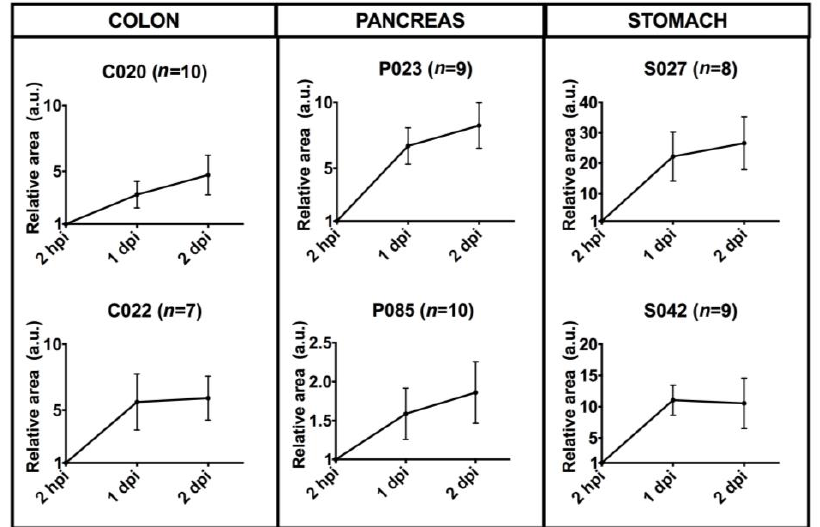
Figure 8. Quantitative analysis of six cases of patient-derived tumor xenografts. Dil-stained area at time points 2 hpi, 1 dpi and 2 dpi were normalized with respect to the time point 2 hpi. Patient enrollment codes are reported (C=Colon, P=Pancreas, S=Stomach), and the number of embryos analyzed for each case study is indicated in the image. Results are expressed as mean ± SEM. C020 ( p = 0.04), C022 ( p = 0.05), P023 ( p = 0.003), S027 ( p = 0.02), S042 ( p = 0.02), P085 ( p = 0.06) by 1-way repeated measures ANOVA.